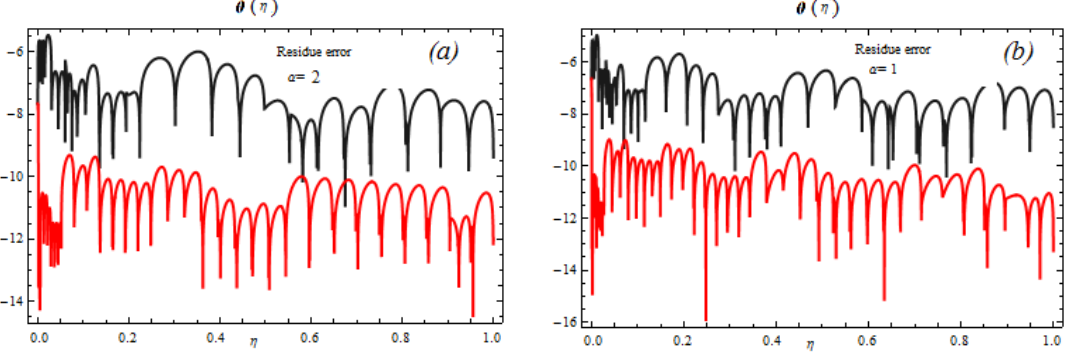
Figure 6. Residue error for temperature for physical parameters ( a ) α = 2 and ( b ) α = 1.